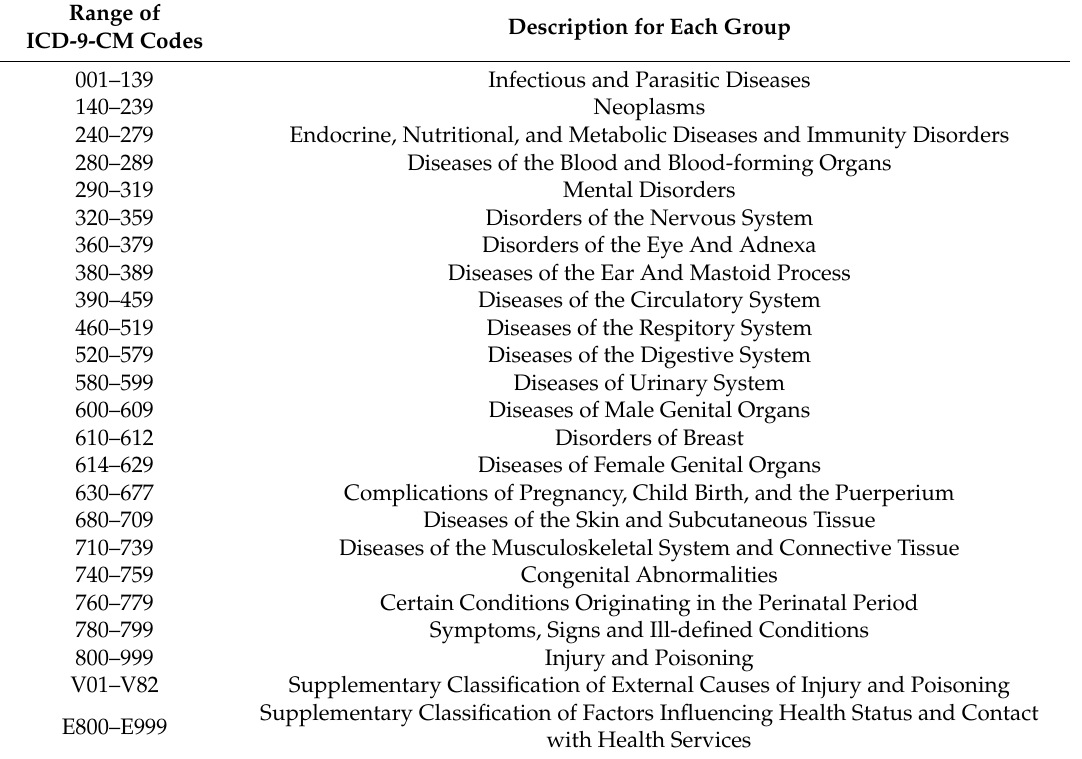
Table 1. Grouping system of ICD-9-CM